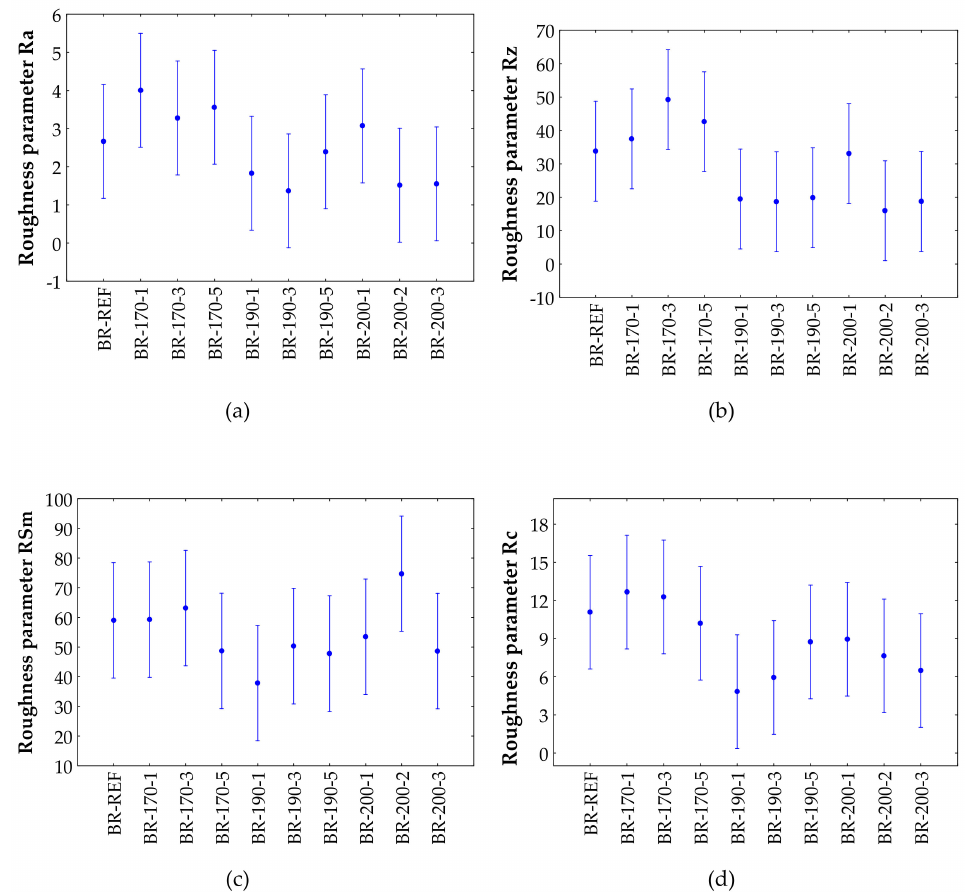
Figure 5. The graphic visualization of the e ff ect of heat-treatment temperature and heat-treatment time limit (peak stage) on roughness parameters determined by optical method ( a ) Ra, ( b ) Rz, ( c ) RSm and ( d ) Rc. BR-REF = untreated birch; BR-170-1 = birch treated at 170 ◦ C / 1 h; BR-170-3 = birch treated at 170 ◦ C / 3 h; BR-170-5 = birch treated at 170 ◦ C / 5 h; BR-190-1 = birch treated at 190 ◦ C / 1 h; BR-190-3 = birch treated at 190 ◦ C / 3 h; BR-190-5 = birch treated at 190 ◦ C / 5 h; BR-200-1 = birch treated at 200 ◦ C / 1 h; BR-200-2 = birch treated at 200 ◦ C / 2 h; BR-200-3 = birch treated at 200 ◦ C / 3 h. Ra = the average arithmetical deviation of the profile; Rz = the distance between the highest peak and the lowest valley in the basic length range; RSm = the average width of the profile elements; Rc = the average height of the